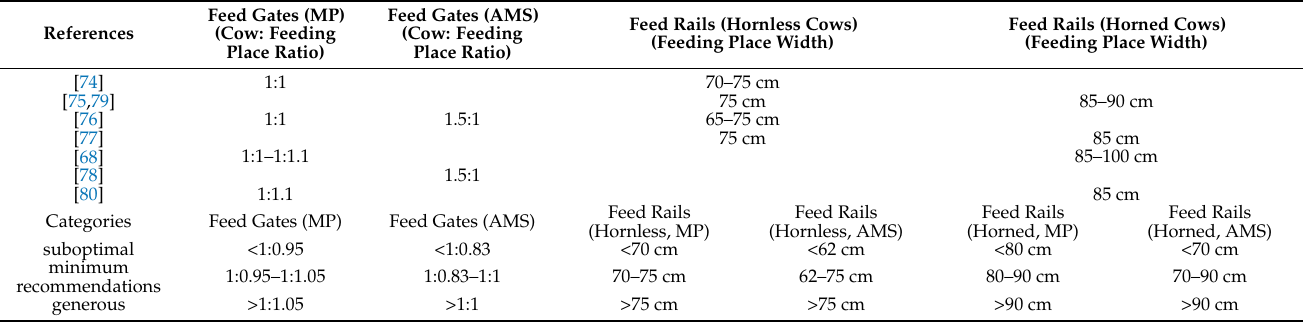
Table A3. Feeding places-recommendations for herds with milking parlor (MP) or automatic milking system (AMS) and with horned or hornless cows, and categories for analyses derived from these